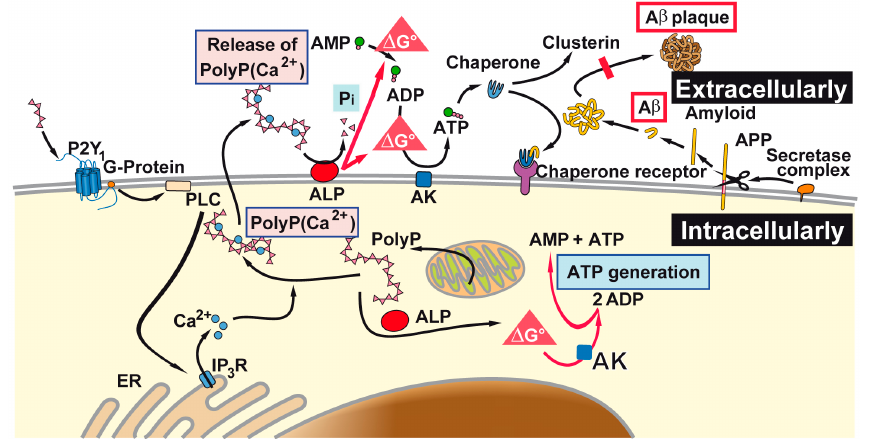
Figure 8. As outlined, polyP microparticles that can be taken up by the cells, or formed there intracellularly, are prone to the alkaline phosphatase (ALP). In analogy to the acidocalcisomes, polyP microparticles are also formed intracellularly, and can subsequently be released by the cells. It is sketched that the (proposed) pathways of ATP generate both intra- and extracellularly Gibbs free energy that is released during the hydrolysis of the anhydride bond in polyP into both compartments. This process can occur both extracellularly [58] and intracellularly. Those adenosine nucleotides provide the energy for the extracellular chaperones which might prevent misfolding of amyloid plaques (abbreviated as A β ). AK: adenylate kinase; AMP: adenosine monophosphate; ADP: adenosine diphosphate; ATP: adenosine triphosphate; ER: endoplasmic reticulum.